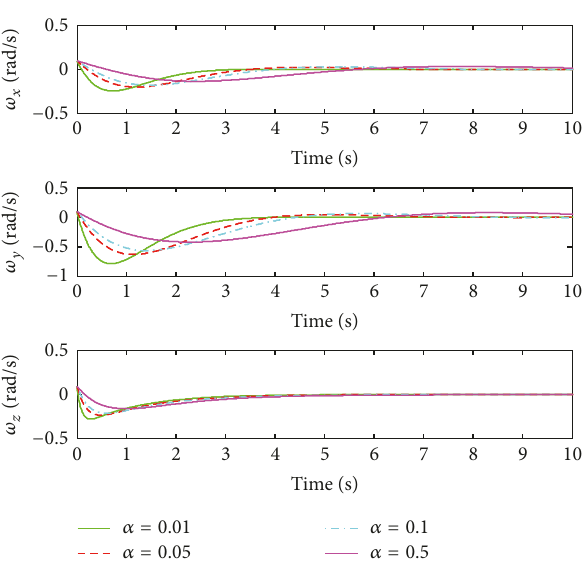
Figure 3: Rotation speeds with different weights.